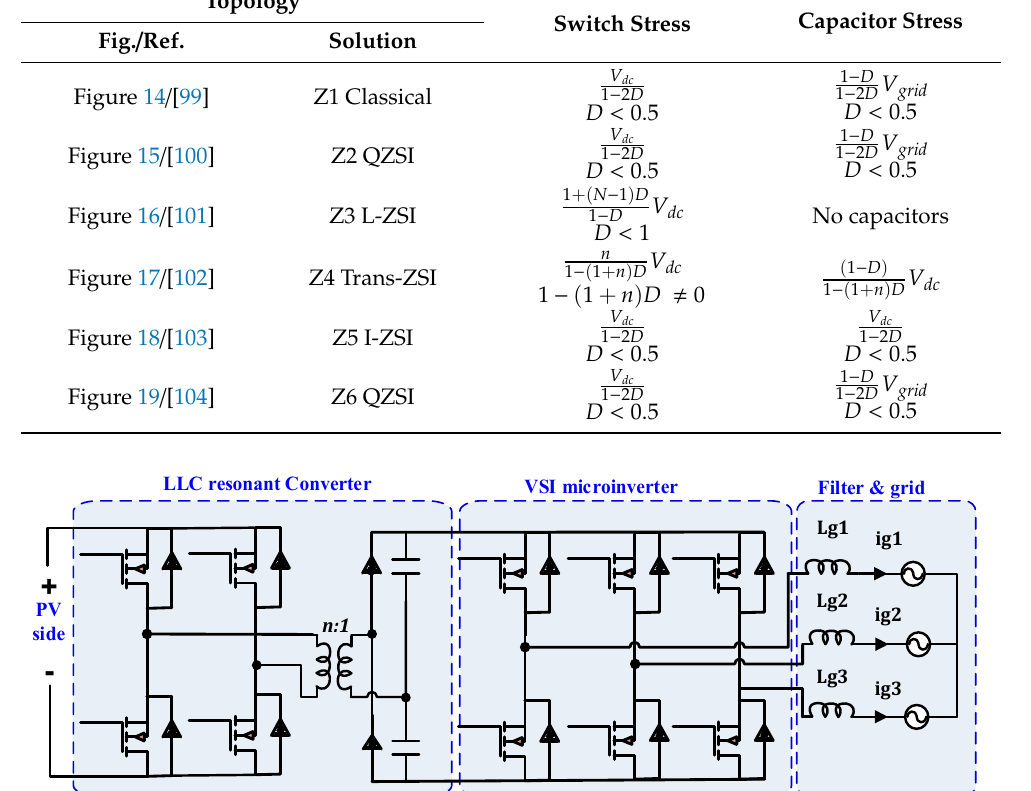
Figure 19. Two-stage three-phase microinverter proposed by Huang and Mazumder [107].